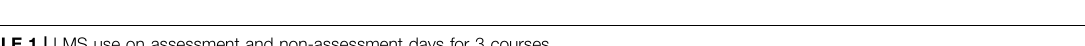
TABLE 1 | LMS use on assessment and non-assessment days for 3 courses.